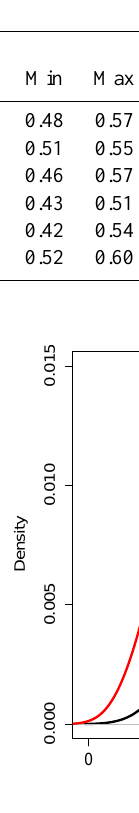
Table 1. Temporal variability in values of α and C1, and the results of Mann-Kendall trend analyses.